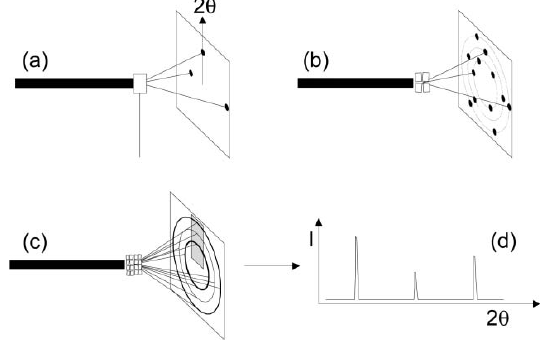
Figure 1. Diffraction from (a) an oriented single crystal, (b) a collection of four crystals and (c) from a polycrystalline material, with (d) the cross-section of the Debye-Scherrer rings ([9]—reproduced by permission of The Royal Society of